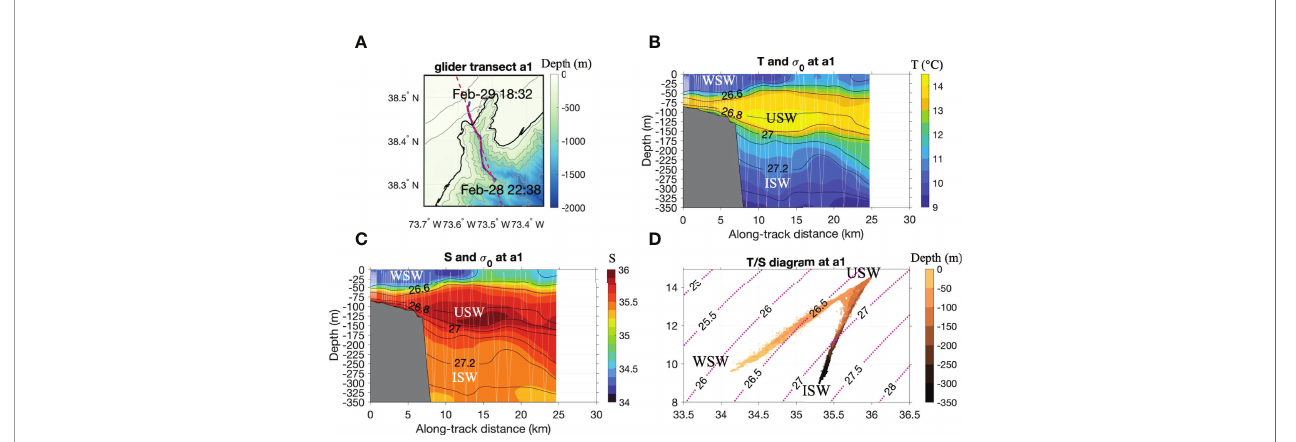
FIGURE 3 | Water masses in the upper 350 m in Wilmington Canyon shown by data at glider transect a1. (A) Purple line indicates glider transect a1. Red dashed line indicates where SCHISM model output was extracted in Figure 6 . (B, C) Spatially interpolated fi elds of temperature and salinity, contours are isopycnals. (D) T/S diagram based on glider data. Three distinctive water masses comprised the upper 350 m of the water column in and around Wilmington Canyon during the glider survey. From surface downward, there were the low-temperature (~ 10°C) and low-salinity (<34.5) winter shelf water (WSW), the high-temperature (~14°C) and high- salinity ( ≥ 35.5) upper slope water (USW), and the low-temperature (~9°C) and high-salinity (~35.3) intermediate slope water (ISW). Each water mass is shown as an end member in the T/S